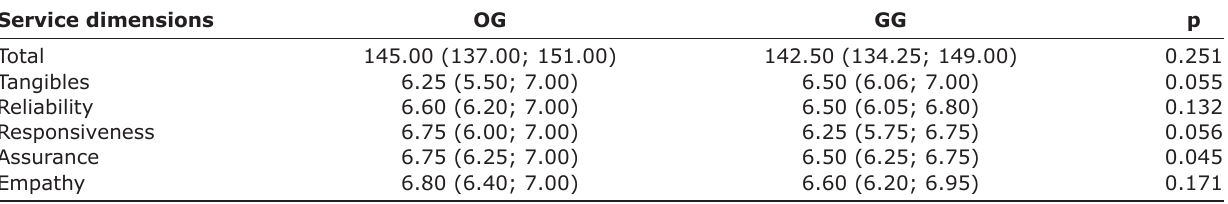
Table-1: Summarized information concerning the results obtained for client expectations. Service dimensions